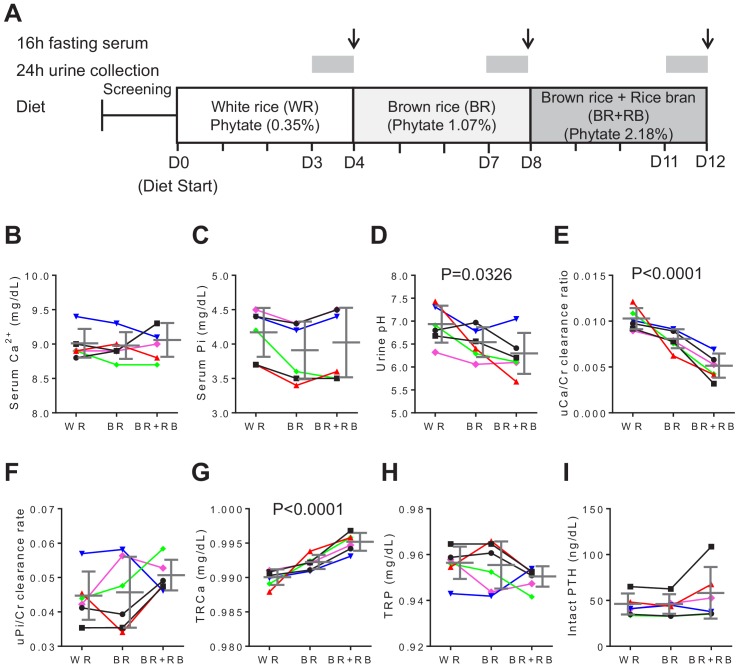
High-phytate diets dysregulate mineral and phosphate metabolism in humans.(A) Experimental design (six healthy female volunteers). (B, C) Time course of serum levels of Ca2+ (B) and phosphate (C) for three different phytate doses. (D–H) Kinetics of urine pH (D), 24 hr urine Ca2+/Cr ratio (E), 24 hr urine Pi/Cr ratio (F), renal tubular Ca2+ reabsorption (TRCa) (G), and renal tubular phosphate reabsorption (TRP) (H) for three different phytate doses. (I) Time-course analysis of serum levels of intact PTH for different phytate doses. Data are presented as the mean ± SD for each dose (n = 6 per dose). Statistical significance was tested by repeated measure ANOVA between subjects and groups. All data are presented as the mean ± SD for each dose (n = 6 per dose).